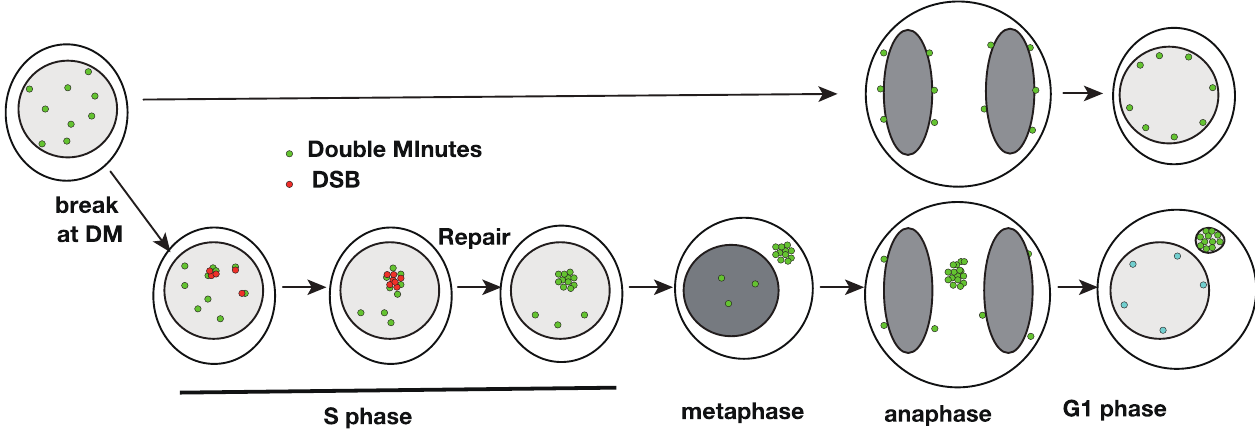
Figure 1. A model explaining how double minute (DM) breakage results in their aggregation, repair, and micronucleation. DM-derived sequences are shown in green, double-strand breakage (DSB) is shown in magenta, and chromatin is shown in gray. Modified from Figure 6G in [30].